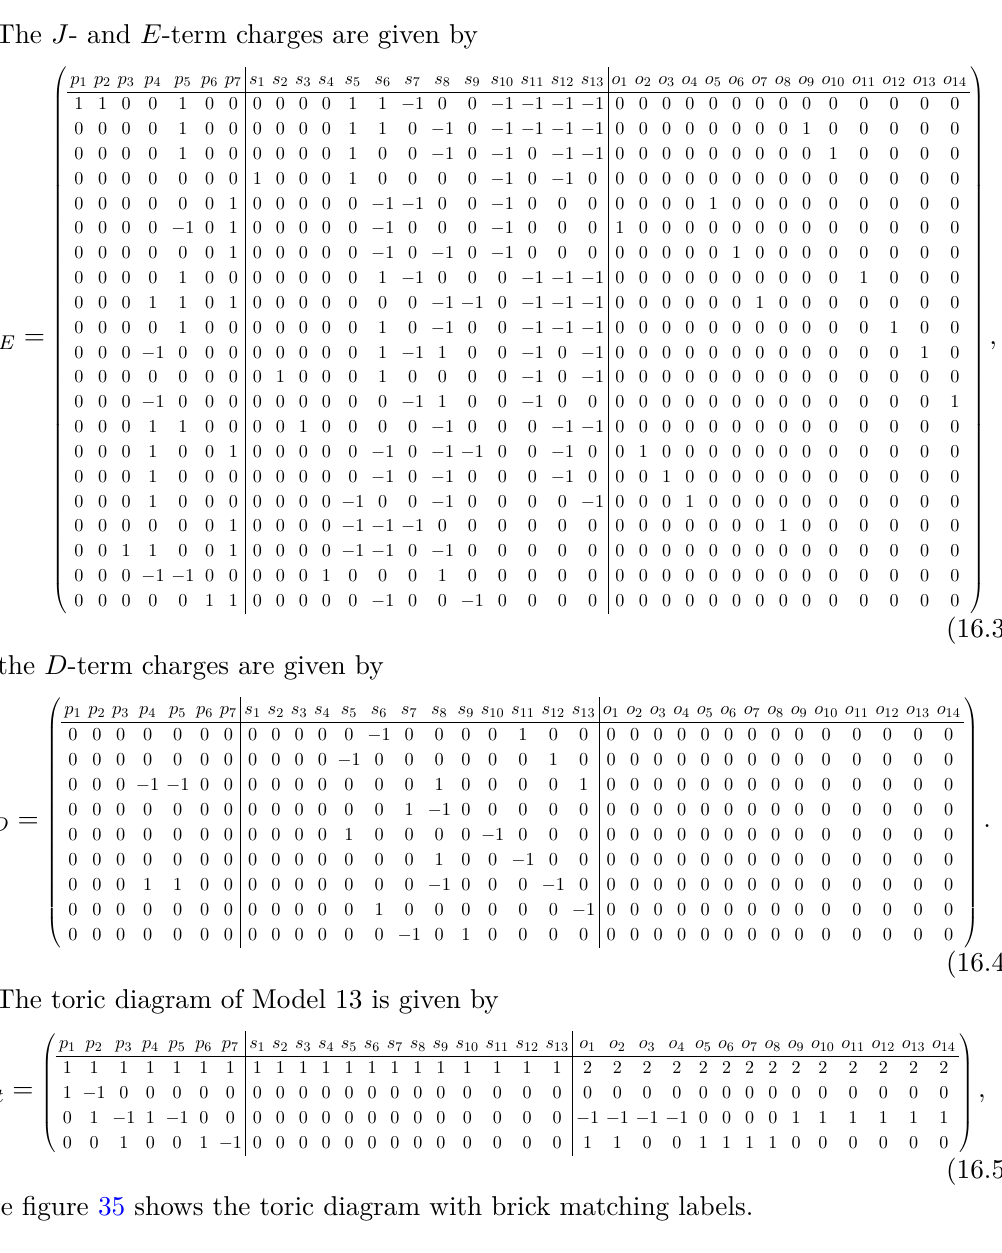
Figure 34 . Quiver for Model